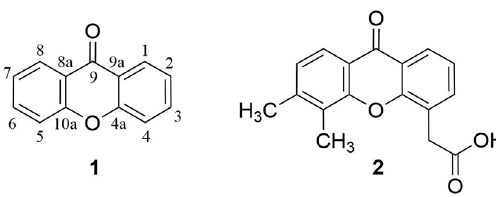
Figure 1. Xanthone scaffold and numbering ( 1 ) and DMXAA ( 2 ).